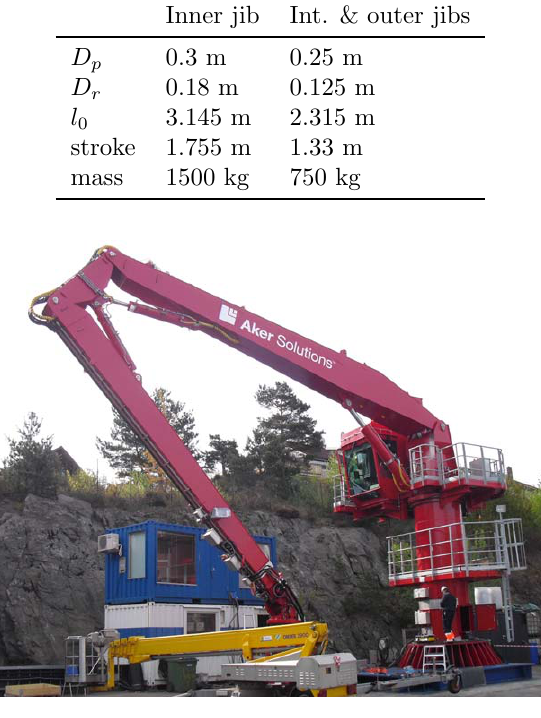
Figure 10: Crane used for experiments.